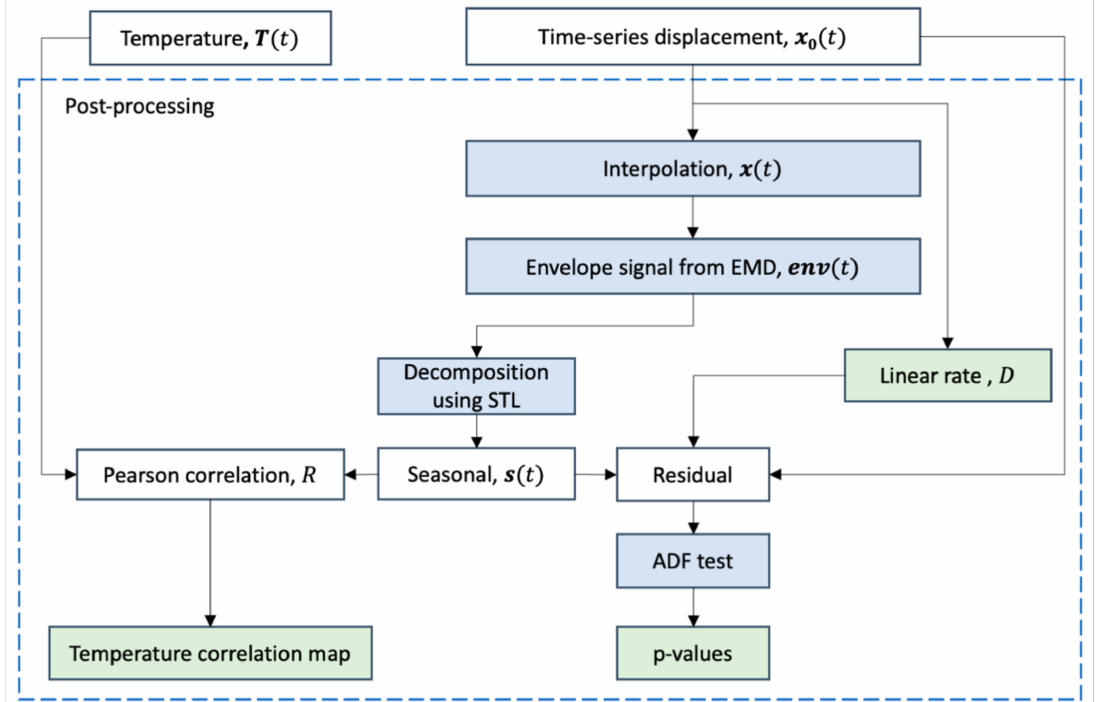
Figure 5. The flowchart of post-processing steps on the InSAR-derived